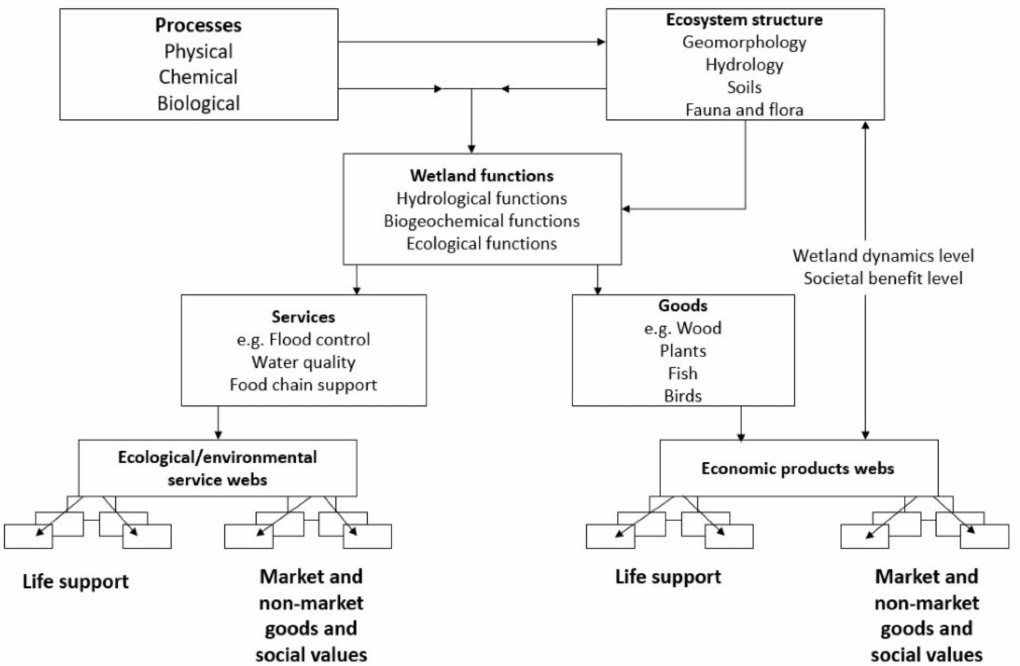
Figure 18. Physical, chemical, and biological processes lie behind the provision of ecosystem ser- vices